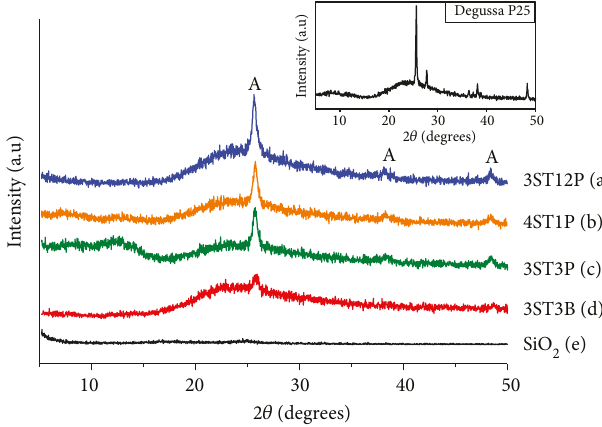
Figure 4: XRD patterns of TiO